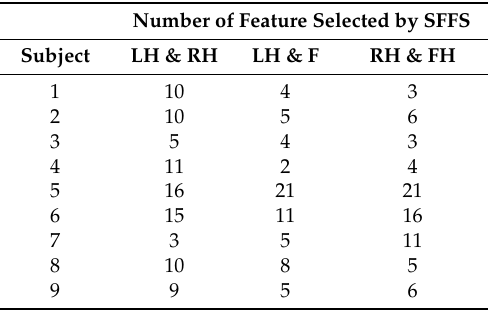
Table 6. The number of features selected using SFFS.